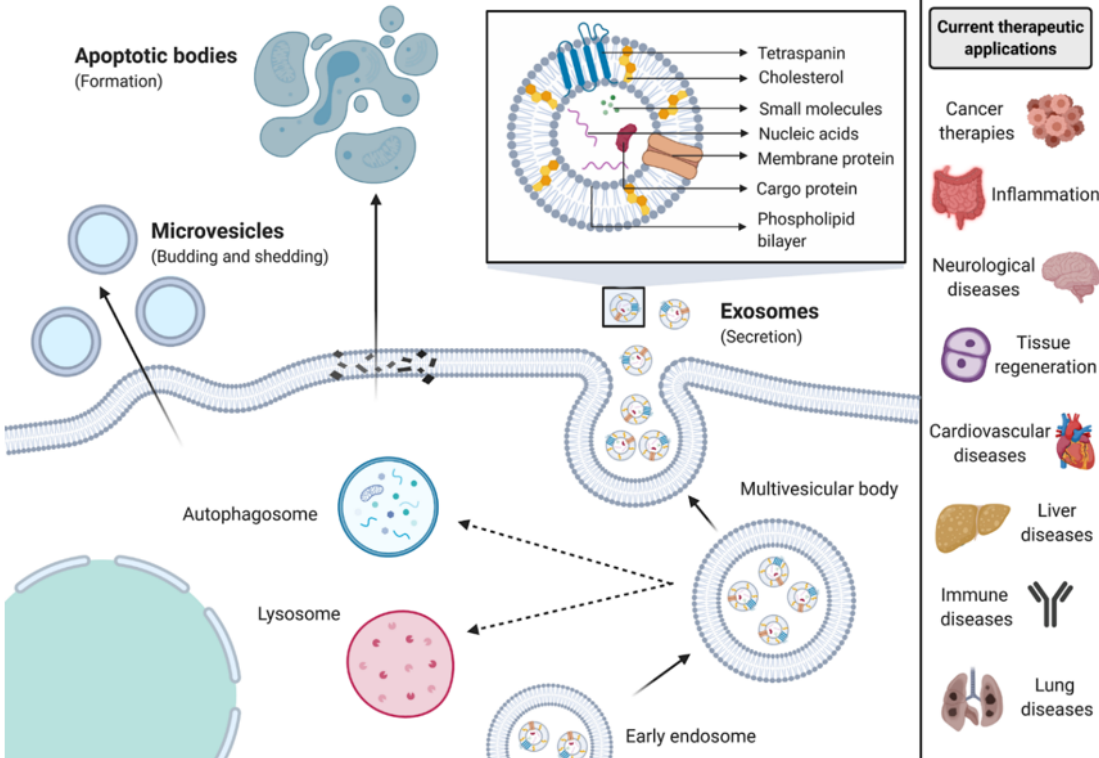
Figure 1. Biogenesis of extracellular vesicles (EVs) and potential applications of these nanoparticles in tissue engineering and regenerative medicine.